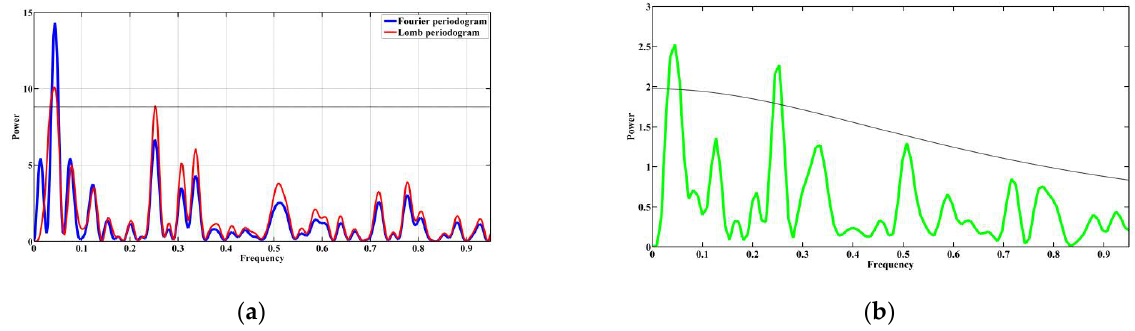
Figure 5. The results of applying spectral methods to the magnetic susceptibility data from the Lower-Upper Pontian deposits of the Zhelezny Rog Cape section (Figure 2a): ( a ) Fourier and Lomb periodograms (the black bold solid line indicates the 95% confidence interval for the Lomb periodogram); ( b ) the spectrum constructed by the REDFIT algorithm (the black bold solid line indicates the 95% confidence interval).